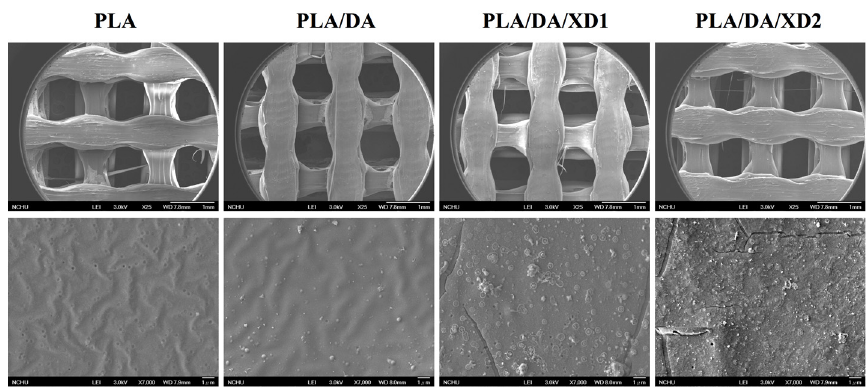
Figure 3. SEM images of PLA scaffold coated with DA and XD.